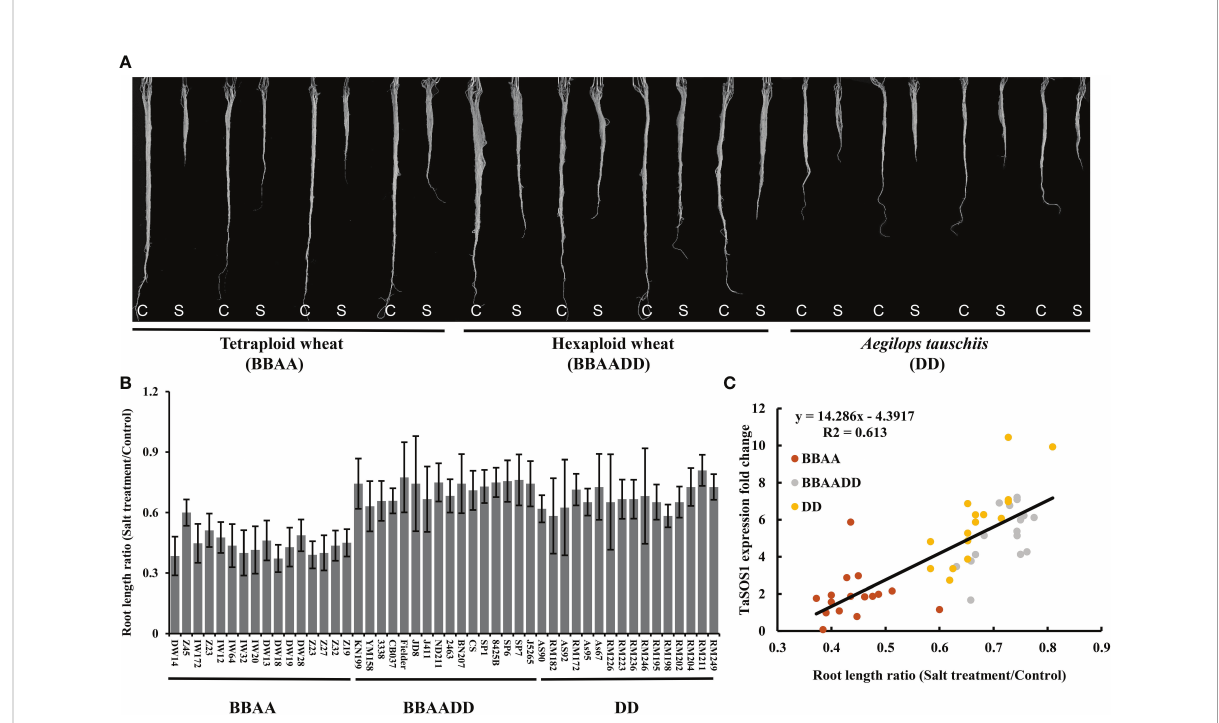
FIGURE 4 Expression of SOS1 gene was correlated with salt tolerance variation in wheat accessions of different ploidy. (A) Example of root length phenotype of natural wheat accessions before and after 200 mM NaCl treatment. C: Control; S: Salt treatment. (B) A quantitative assessment of the roots length for 48 natural wheat accessions. The y-axis denotes a ratio of NaCl-treated seedlings relative to the same genotype grown on control condition. Mean and SD values were derived from measurements of at least 20 seedlings from three independent assays. (C) Correlation coef fi cients between the roots length ratio (Salt treatment/Control) and the expression levels of TaSOS1 among different ploidy wheat accessions. The x-axis denotes a ratio of NaCl-treated seedlings relative to the same genotype grown on control condition. The y-axis denotes the fold change of TaSOS1 up-regulation expression in root of wheat accessions with different ploidy before and after 200 mM NaCl